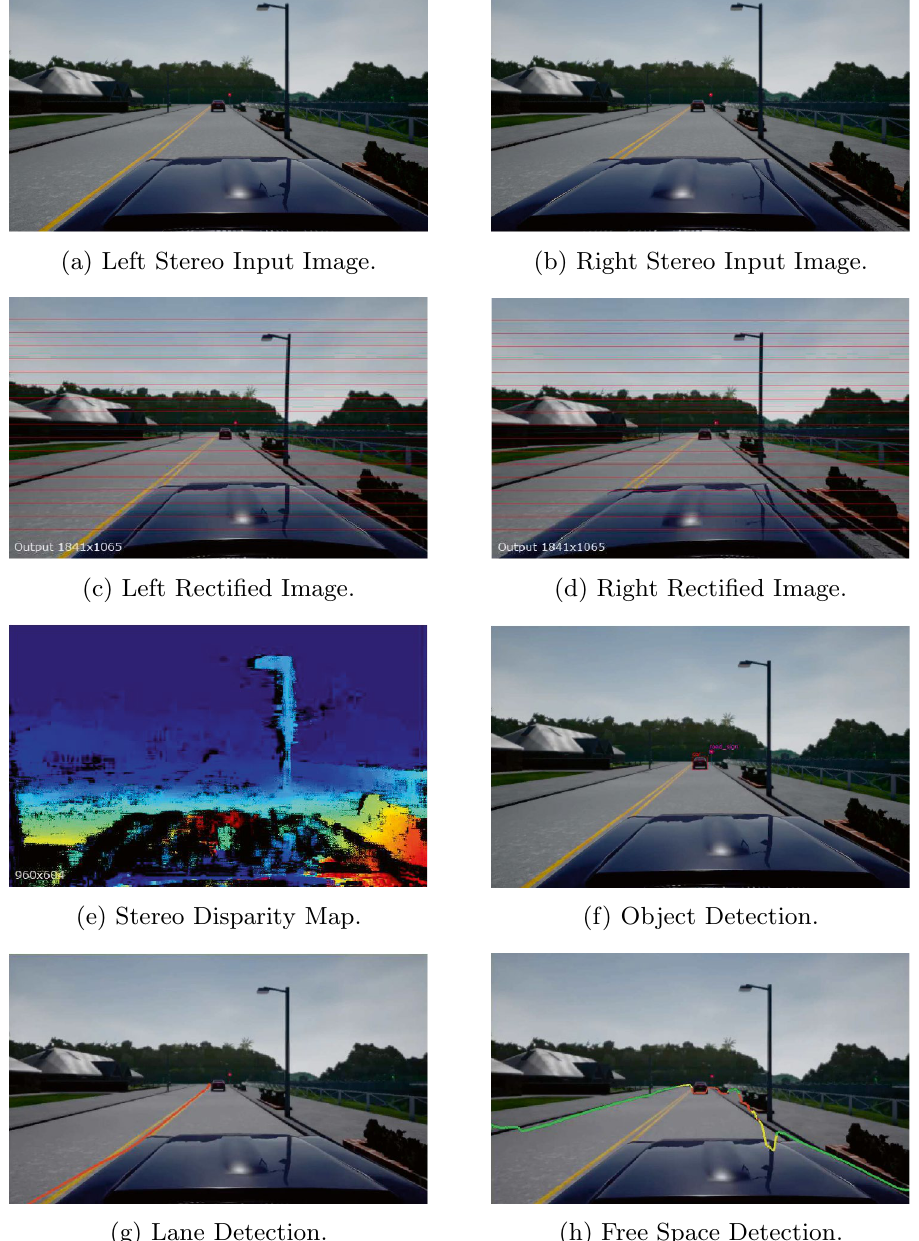
Fig. 15h. Our final output of a stereo vision software is dis- played in Fig. 16.